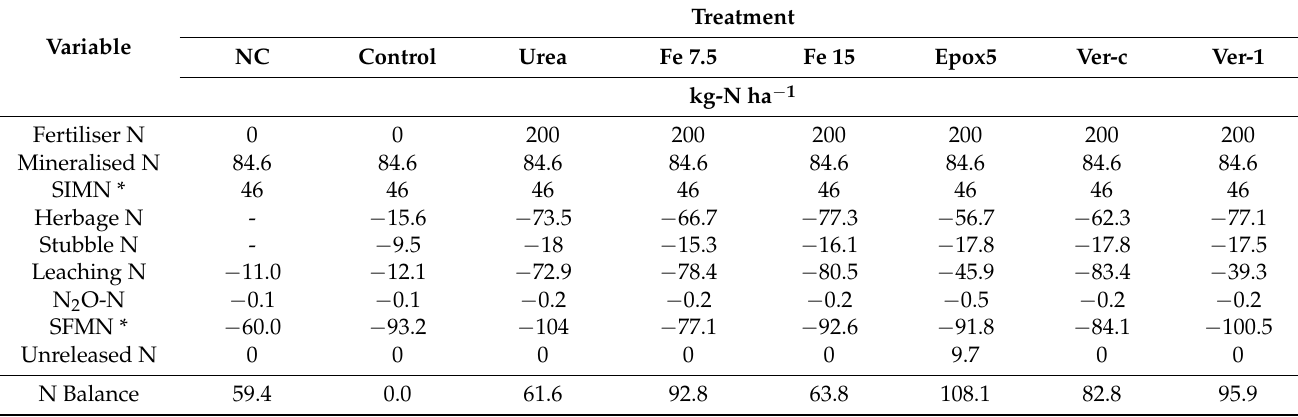
The mineralisation during the experimental period was calculated using the N bal- 84.6 kg-N ha − 1 and was assumed as the N mineralisation value for all other treatments observed in the Epox5 treatment (Table 3). The surplus N balance in this study could be attributed to the following reasons; unmeasured N components, such as root N, ammonia volatilisation, immobilisation and denitrification. In addition, using the N mineralisation value calculated for the control could be an overestimation for all other treatments. The rate of mineralisation of the fertilised soil is lower than that of the unfertilised soil in cultivated land use (control) [25]. Table 3. The N balance of different treatments. Table 3. The N balance of different treatments. Variable